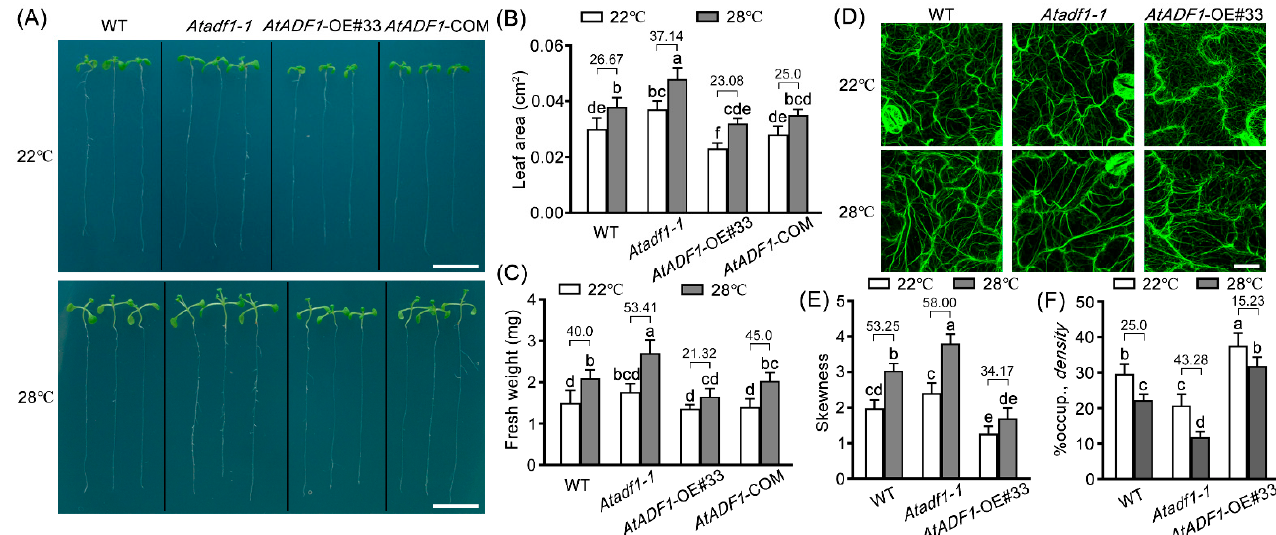
Figure 2. AtADF1 negatively regulates plant growth and inhibits the stability of actin filaments under high temperature. ( A ) The thermal adaptation of WT, Atadf1-1 , AtADF1 -OE#33, and AtADF1 -COM seedlings was visualized. Three-day-old seedlings of WT, Atadf1-1 , AtADF1 -OE#33, and AtADF1 -COM were transferred into a 28 °C chamber for four days. Scale bar = 1 cm. ( B , C ) Leaf area and fresh weight of WT, Atadf1-1 , AtADF1 -OE#33, and AtADF1 -COM seedlings at normal (22 °C) and high temperature (28 °C). At least 60 leaves from 30 seedlings were examined in ( B ) and at least 300 seedlings were examined in ( C ) for per genotype and treatment. Values are mean ± SD from three independent replicate experiments. All of statistical analysis use one-way ANOVA followed by a Tukey’s post-hoc test. Significant differences were indicated by different lowercase letters. ( D ) Representative images of the actin filaments in leaf pavement cells of WT, Atadf1-1, and AtADF1 - OE#33 seedlings grown at 22 °C and 28 °C. Scale bar = 25 μ m. ( E , F ) The skewness and average filament percentage of occupancy, or density of actin filaments were measured on images shown in ( D ). Values are means ± SD (n > 300 images from at least 30 seedlings for per genotype and treat- ment). All of statistical analysis use one-way ANOVA followed by a Tukey’s post-hoc test. Signifi- cant differences were indicated by different lowercase letters. The number on the column in ( B , C , E , F ) is the percentage of increase or decrease between normal and high temperature conditions.